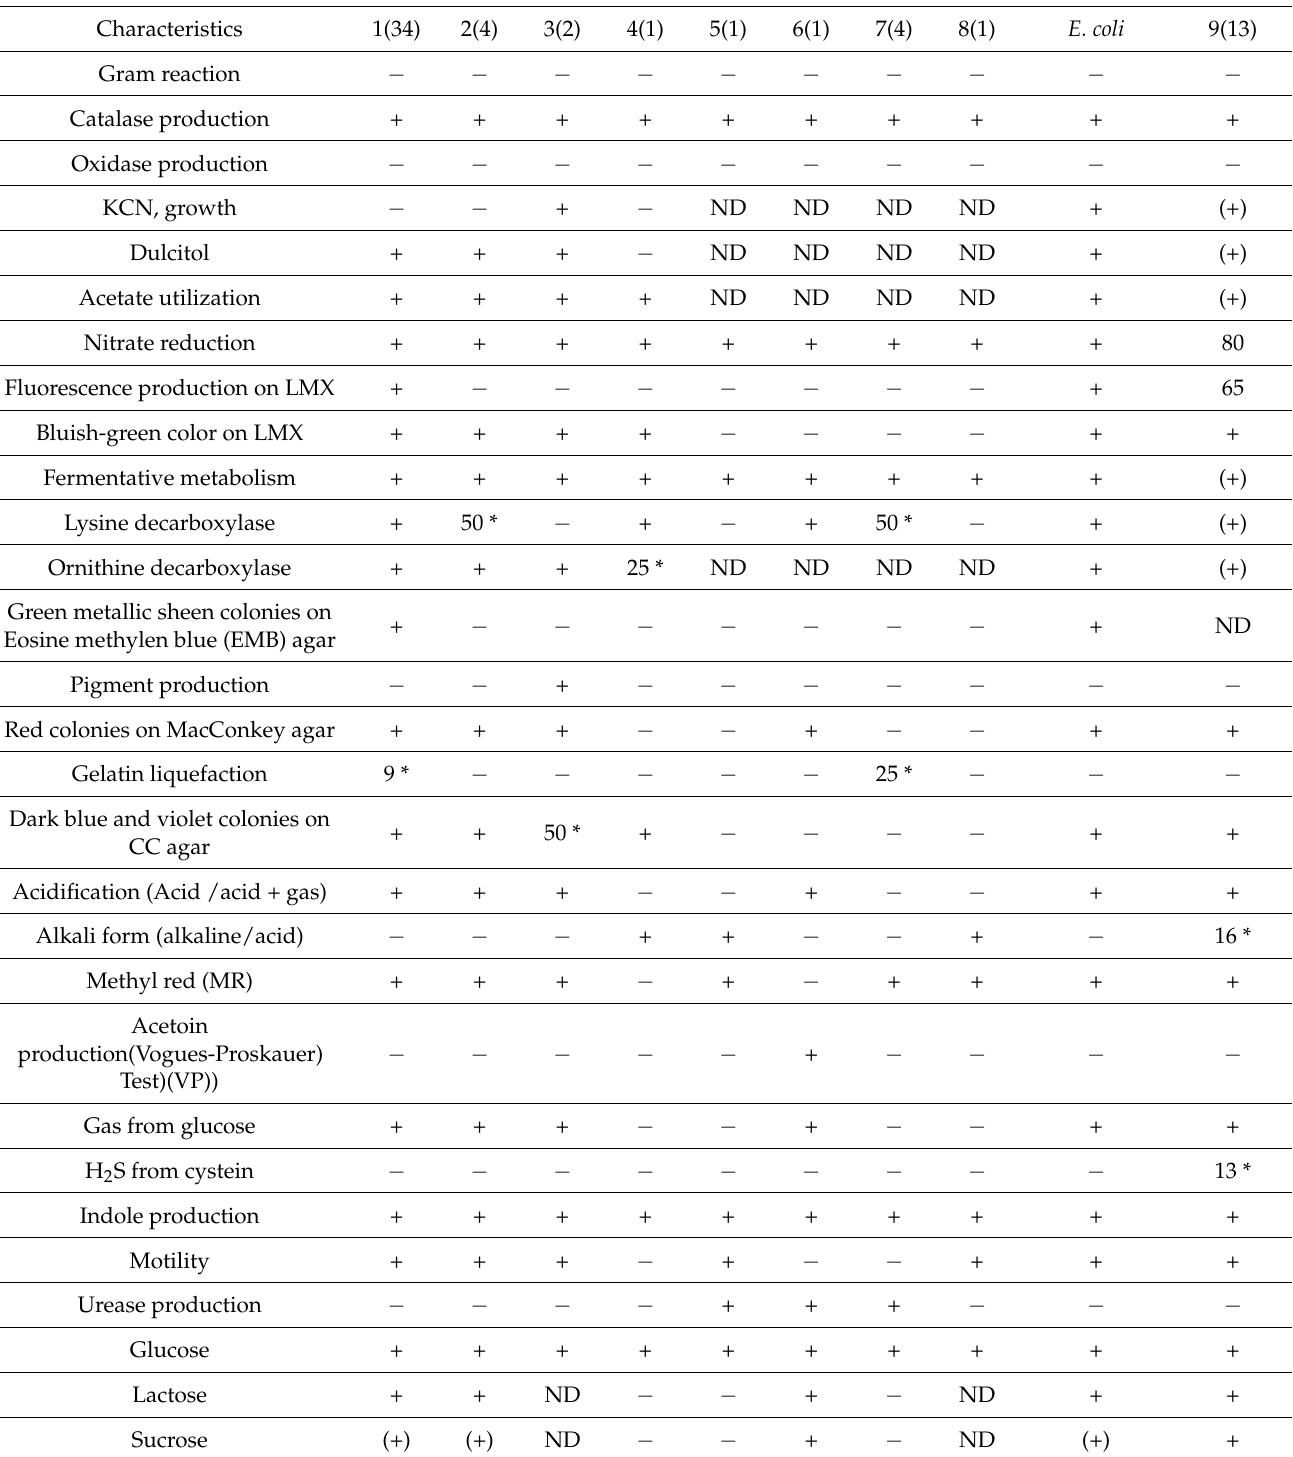
Table 2. Characteristics of coliform strains from ice cream compared with milk and reference strain of E. coli